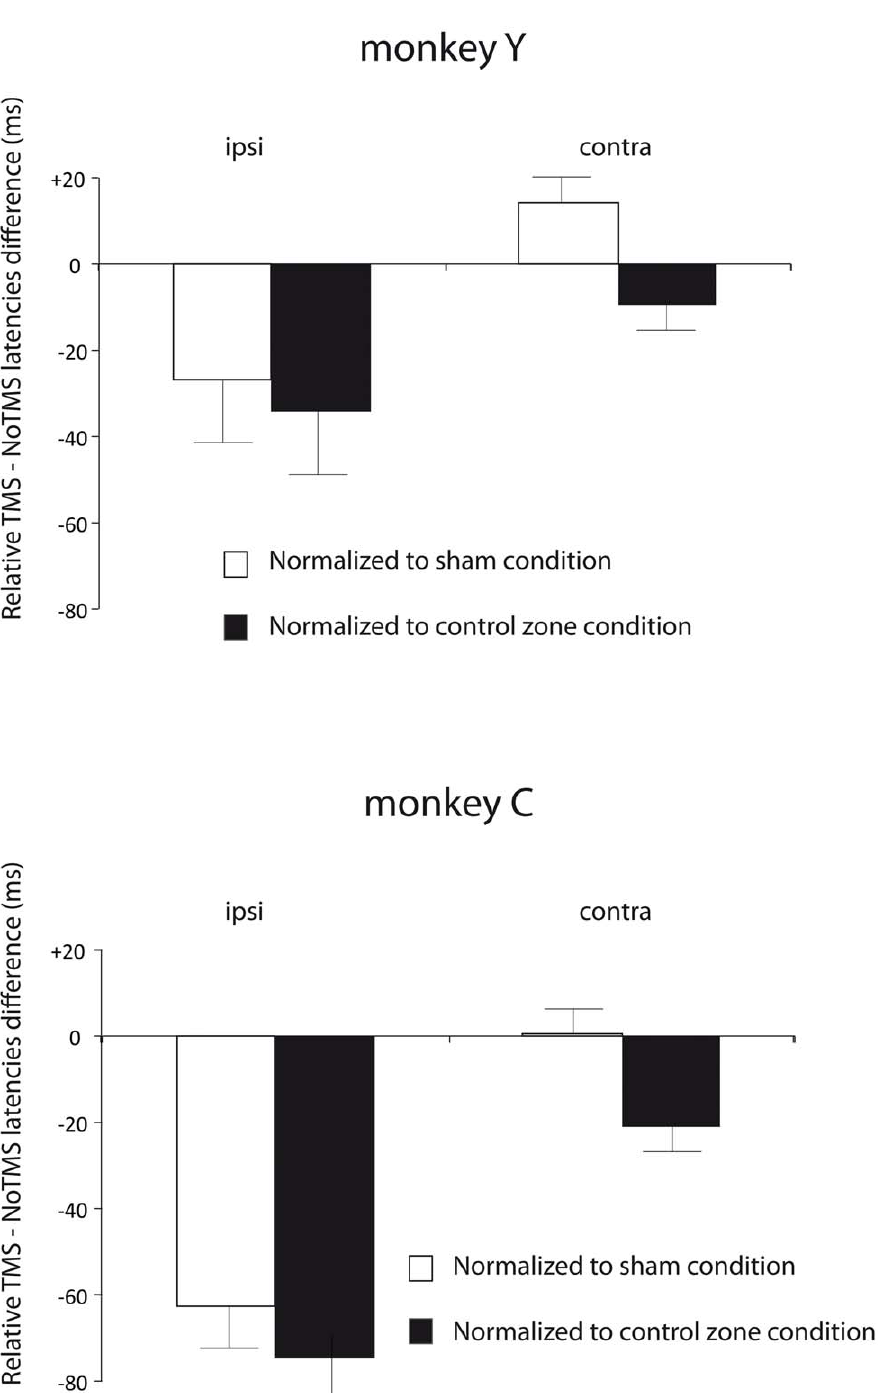
Figure 5. Saccade latencies in TMS or no-TMS trials. Relative modulation of antisaccades latencies (mean and SD) under the impact of online FEF TMS normalized by the effects of sham TMS (white columns; (real TMS-noTMS)-(sham TMS-noTMS)) on the FEF, or active stimulation on a control cortical site (black columns; (real TMS-noTMS)-(active control TMS-noTMS)). Data are shown in millisecond differences for each of the two monkeys (‘C’ and ‘Y’) with TMS delivered at a SOA of 150 ms pre-target onset and at high intensity (50%), at which the effects of active FEF TMS were mostly noted in both monkeys (see Supplementary Table S1 for details). Decreases in normalized AS latency differences suggest a TMS-induced acceleration of AS preparation time with regards to the observed effects for sham TMS (white columns) or active TMS (black columns) in a control site and vice- versa. Notice that in both animals (‘C’ and ‘Y’) active TMS pulses decreased the average latency differences of the AS towards the hemifield ipsilateral to the stimulated FEF, whereas changes were marginal or null for contralateral AS.